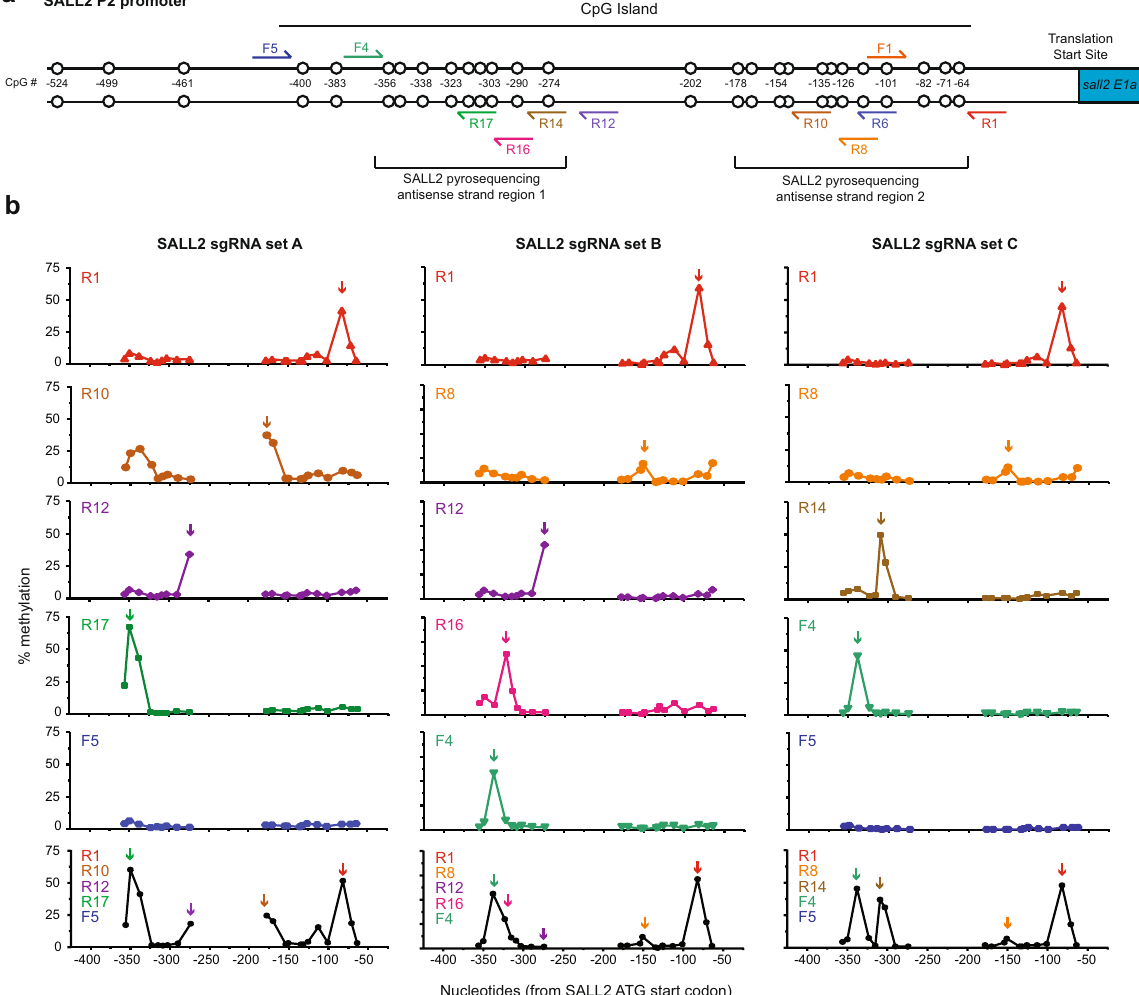
Figure 6. Highly-specific targeting of methylation in the SALL2 P2 promoter using single and multiplexed sgRNAs. ( a ) Schematic of the human SALL2 P2 promoter with sgRNA binding sites and CpG sites (circles) marked by distance from the translation start site of the sall2 E1A isoform. ( b ) Representative pyrosequencing data showing the percent methylation in the SALL2 promoter in HEK293T cells cotransfected with pCMV- sMTase and the indicated single or the following multiplexed sgRNAs: SALL2 sgRNA set A (R1, R10, R12, R17 and F5), SALL2 sgRNA set B (R1, R8, R12, R16 and F4), and SALL2 sgRNA set C (R1, R8, R14, F4 and F5). Supplementary Fig. S6 shows overlays of the methylation patterns. The F5 sgRNA targets a site outside the pyrosequencing region but was included to show the lack of off-target methylation at other